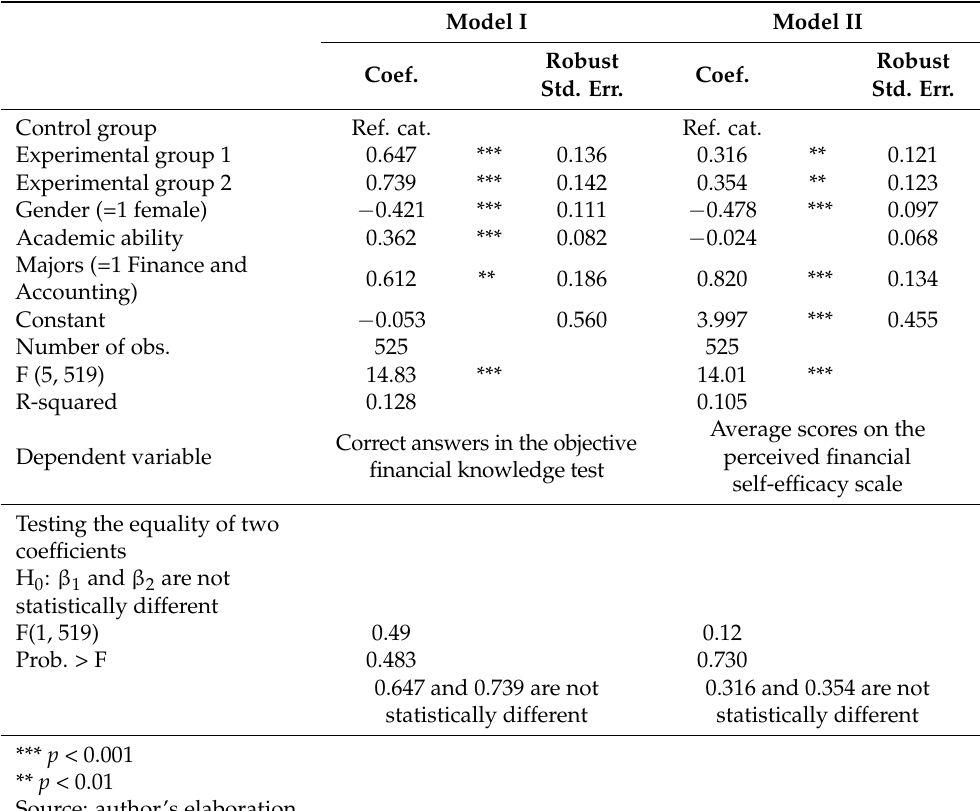
Table 4. Financial education for decision making on graduate studies: Assessing the intervention effectiveness.